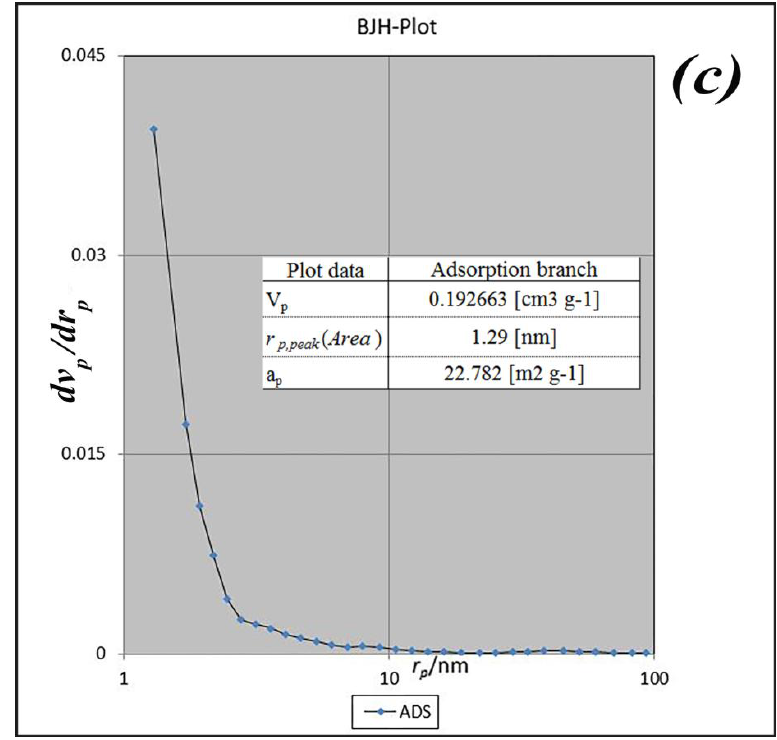
Figure 7. ( a ) Adsorption/desorption isotherms; ( b ) BET and ( c ) BJH plot of nano-MIL-100.